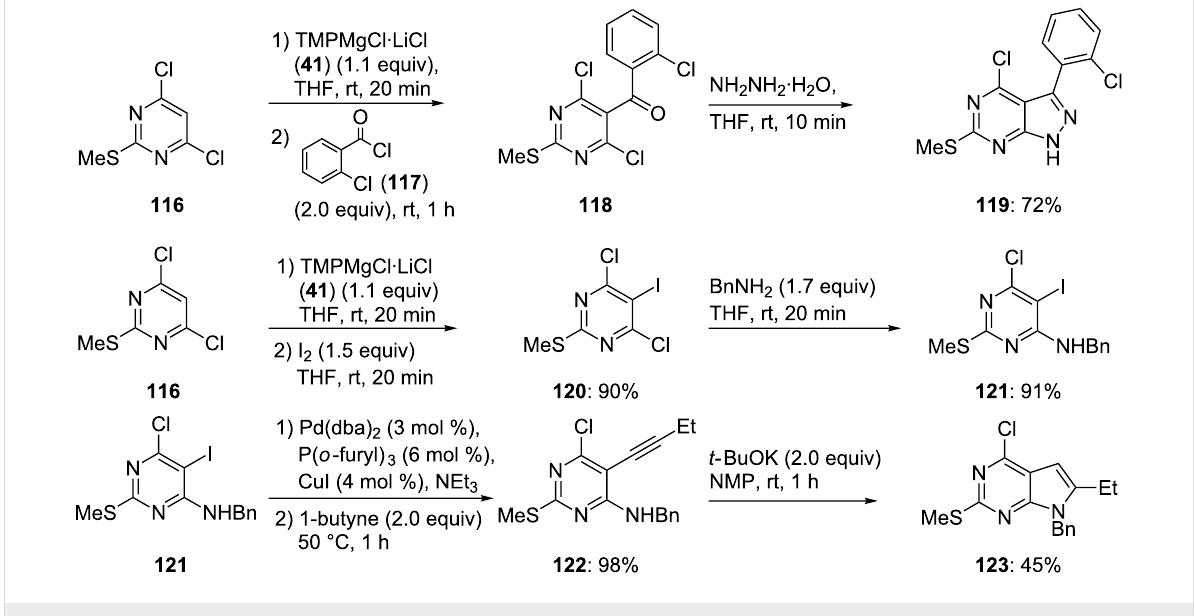
Scheme 19: Synthesis of a p38 kinase inhibitor 119 and of a sPLA2 inhibitor 123